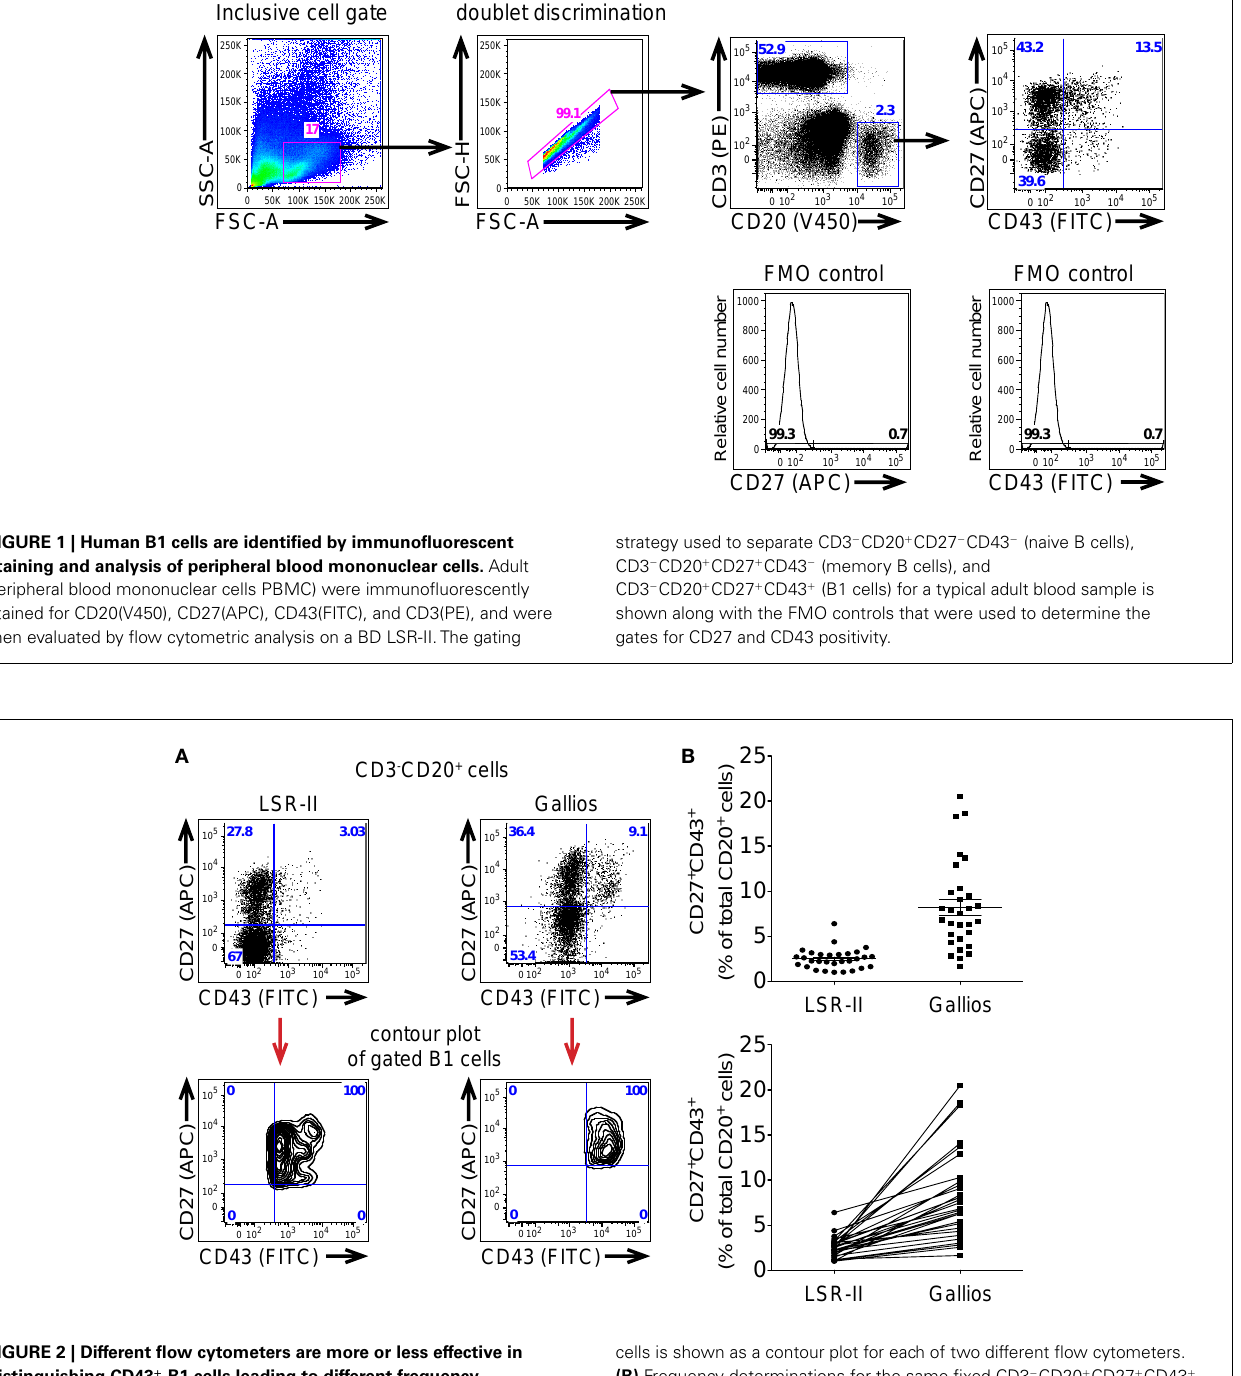
cells is shown as a contour plot for each of two different flow cytometers. (B) Frequency determinations for the same fixed CD3 − CD20 + CD27 + CD43 + (B1) cells analyzed on a BD LSR-II flow cytometer and a Beckman-Coulter Gallios flow cytometer are shown in the top plot, along with lines indicating mean values and standard errors of the means ( n = 30), while the same values for B1 cell frequencies are shown in the bottom plot along with connector lines identifying the same sample on each